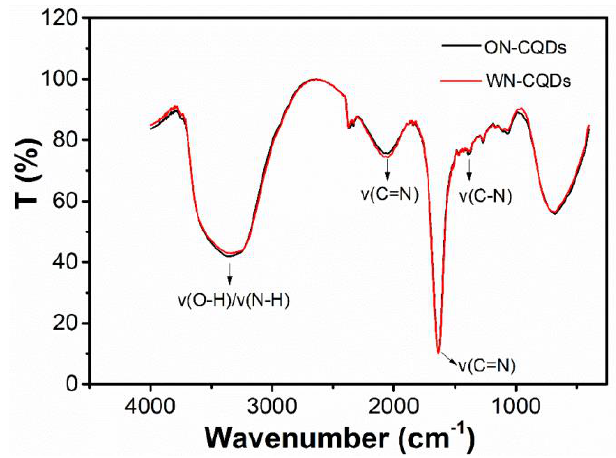
Figure 4. FTIR spectrum of ON-CQDs (black) and WN-CQDs (red).